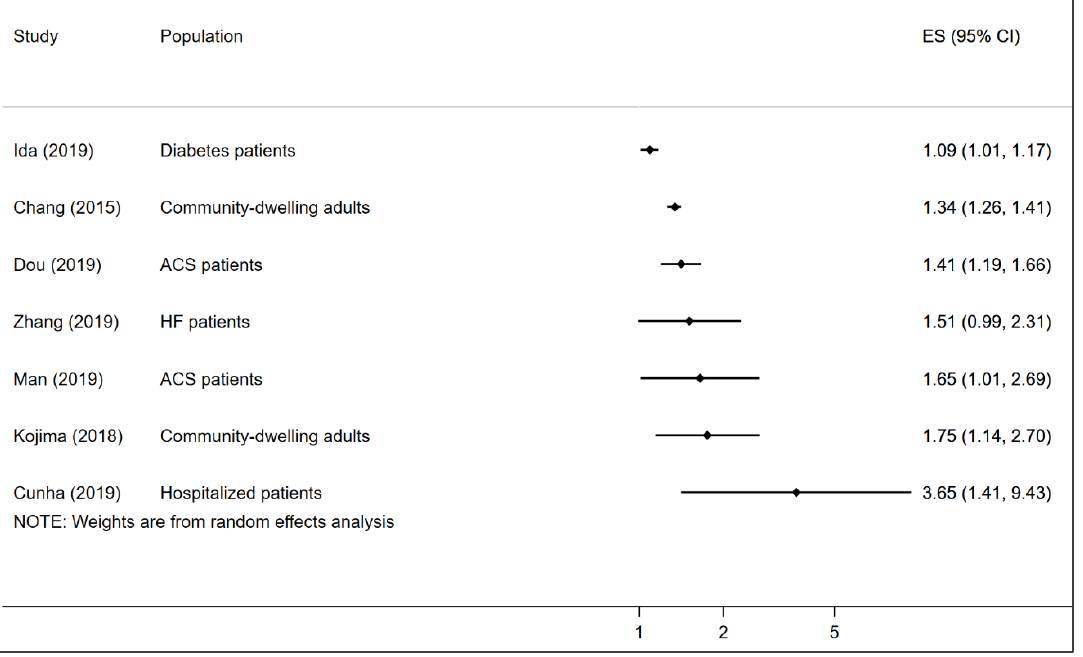
Figure 3. Forest plot showing the reported HR/RR of the association between pre-frailty and all-cause mortality across the included meta-analyses. ACS = acute coronary syndrome; HF = heart failure.